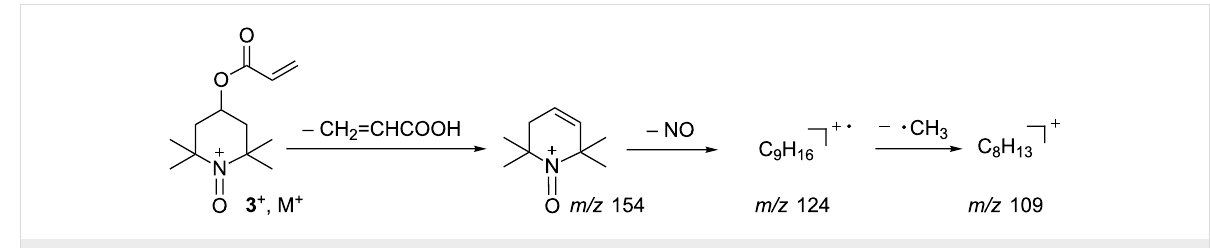
Scheme 2: The formation of the fragment ions at m / z 154, 124, 109.